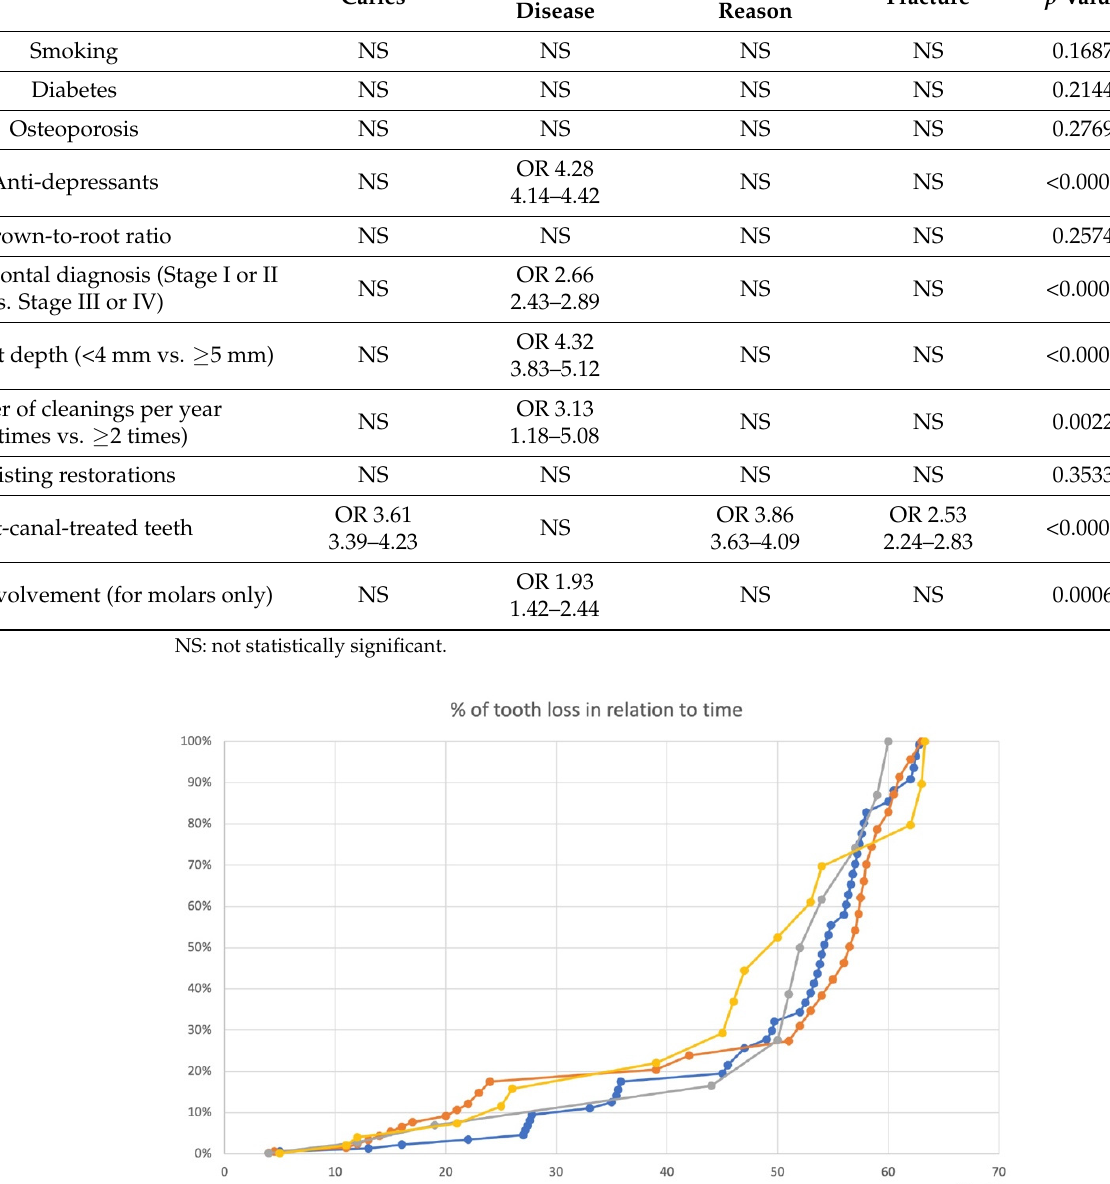
Table 3. Risk indicators of tooth loss for each category using a linear mixed model.